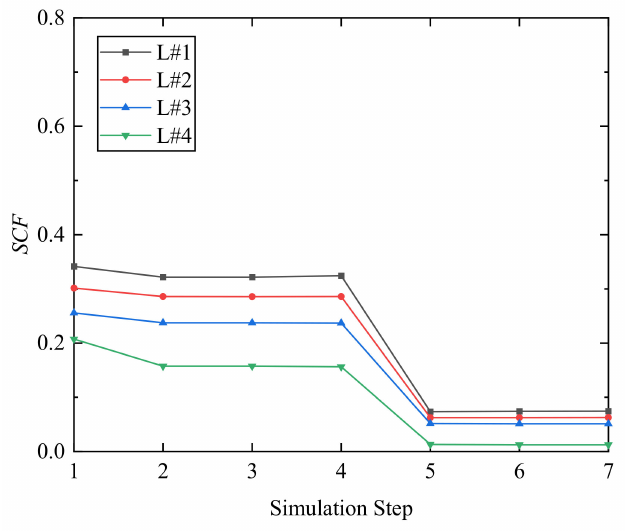
Figure 9. Comparison of SCF of SCN-5 among four mining